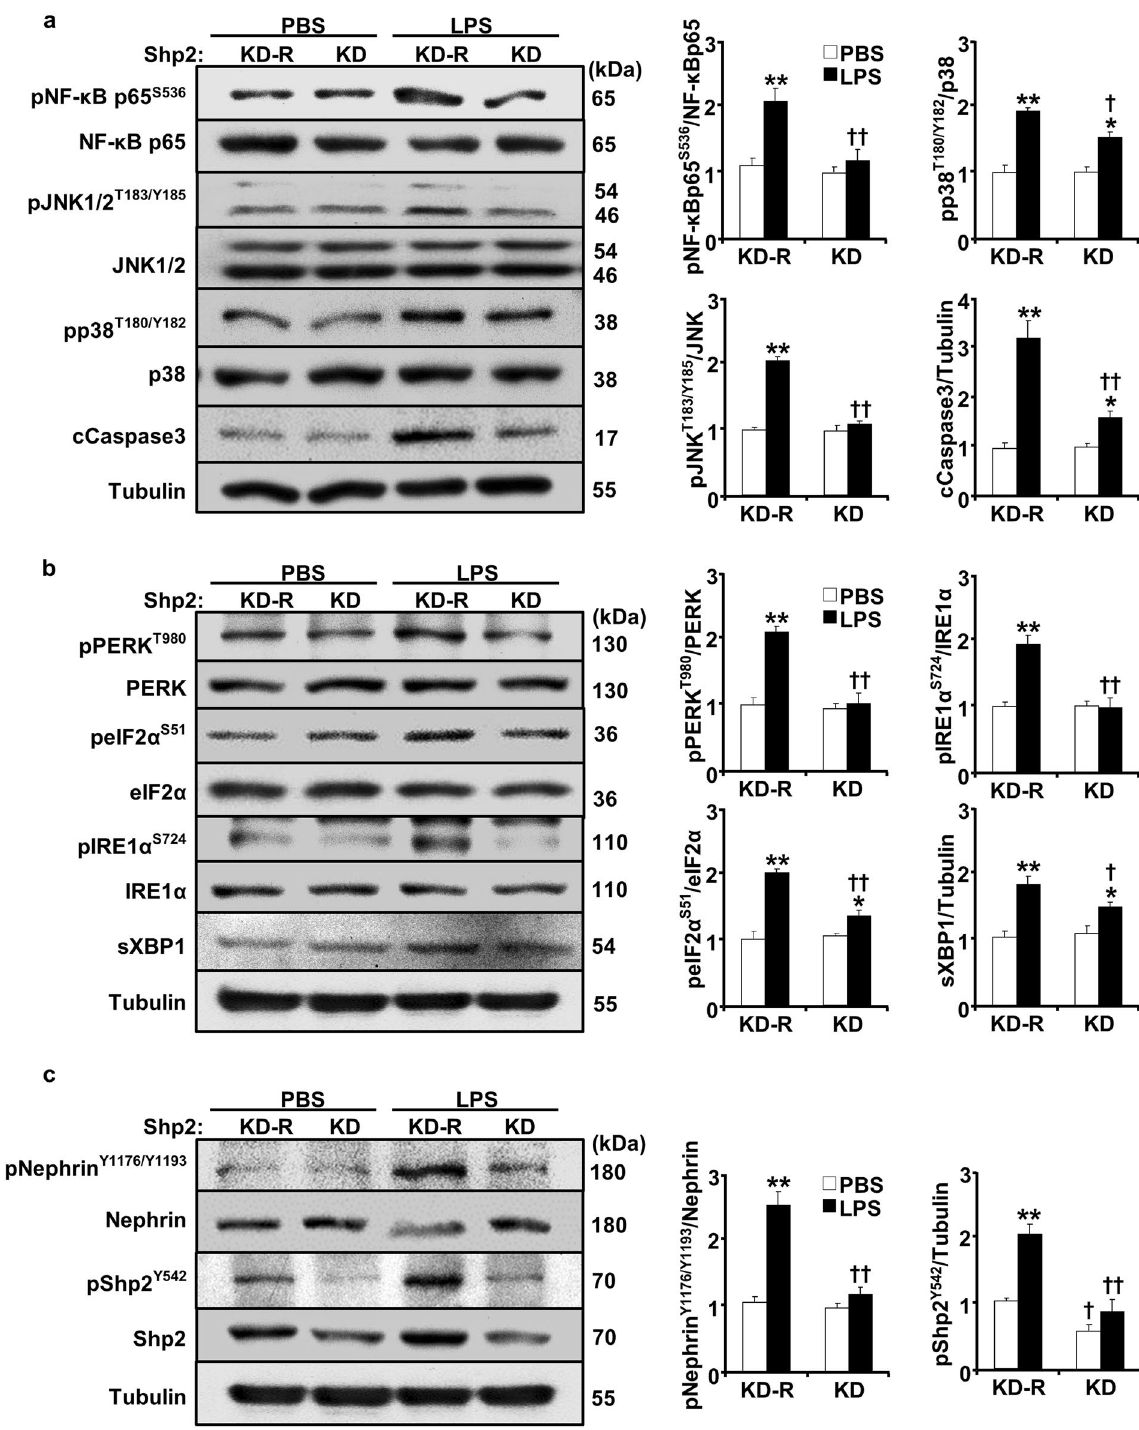
Figure 6. Shp2 deficiency in E11 podocytes attenuates LPS-induced inflammatory response and ER stress. Differentiated podocytes with Shp2 knockdown (KD) and rescue (KD-R) were treated with PBS and with LPS for 24 hours. Cell lysates were subjected to immunoblots with primary antibodies as indicated. Representative images are shown. Bar charts of pNF- κ B p65/NF- κ B p65, pJNK/JNK, pp38/p38, cleaved Caspase3/tubulin ( a ), pPERK/PERK, peIF2 α /eIF2 α , pIRE1 α /IRE1 α and sXBP1/tubulin ( b ), pNephrin/Nephrin and pShp2/tubulin ( c ) are presented as means + SEM from three independent experiments. * p < 0.05 and ** p < 0.01 indicate a significant difference between PBS and LPS treatments; † p < 0.05 and †† p < 0.01 indicate a significant difference between KD-R and KD podocytes. A.U., arbitrary